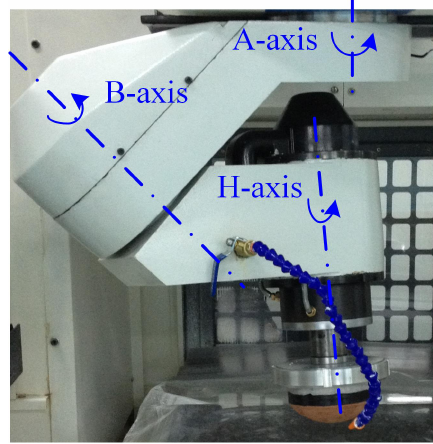
Figure 5. Experimental prototype.